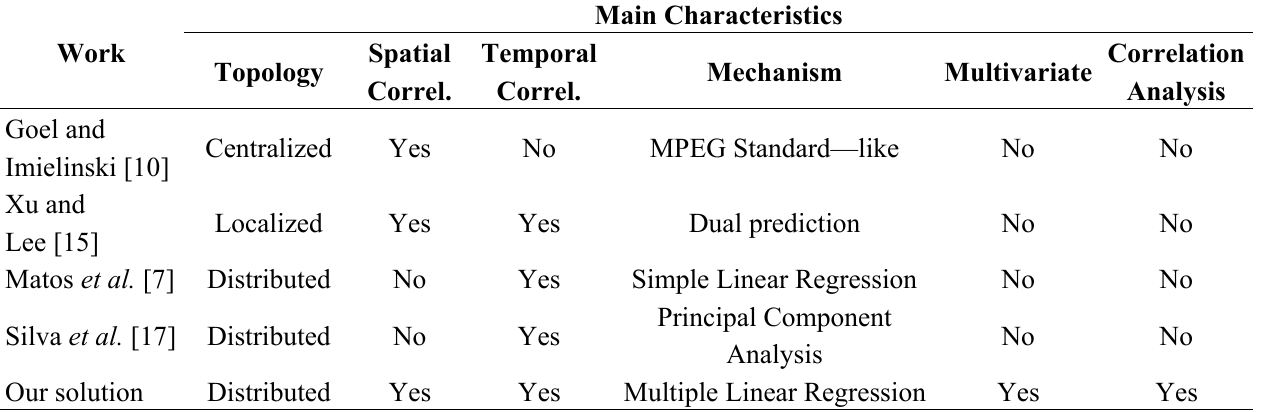
Table 1. Comparison of the main characteristics of